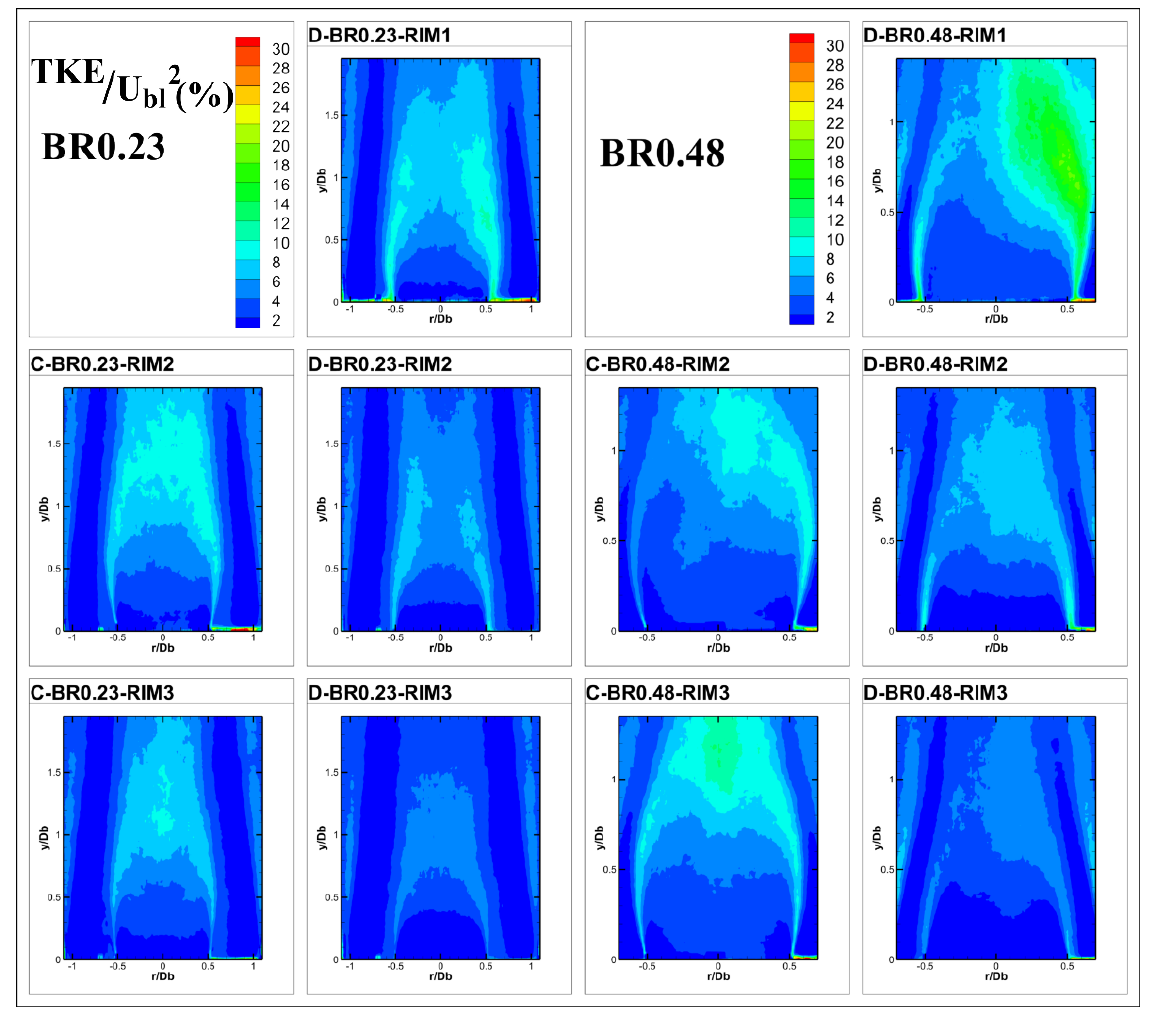
Figure 6. Distributions of normalized 𝑇𝐾𝐸 contours.